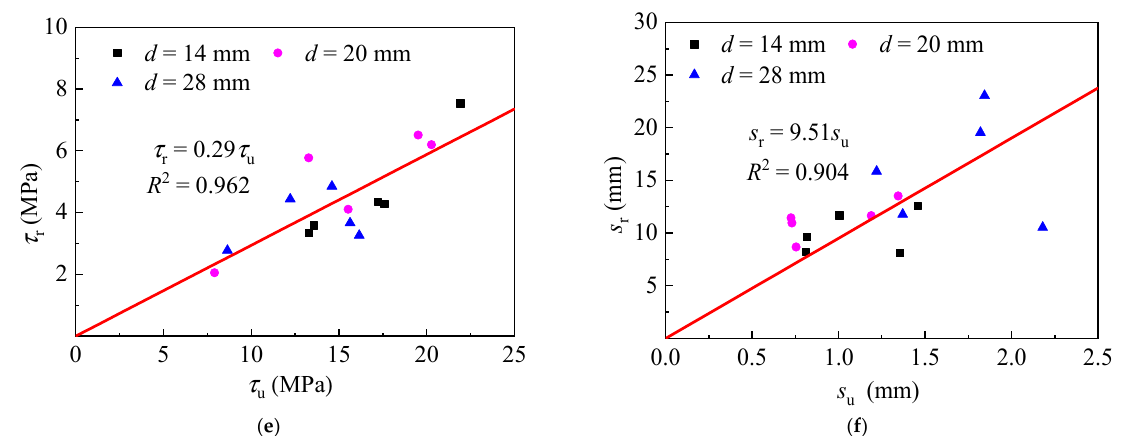
Figure 9. Relationships of bond stress and slip at key points with bond strength τ u and peak-slip s u : ( a ) τ cr ; ( b ) s cr ; ( c ) τ s ; ( d ) s s ; ( e ) τ r ; ( f ) s r .